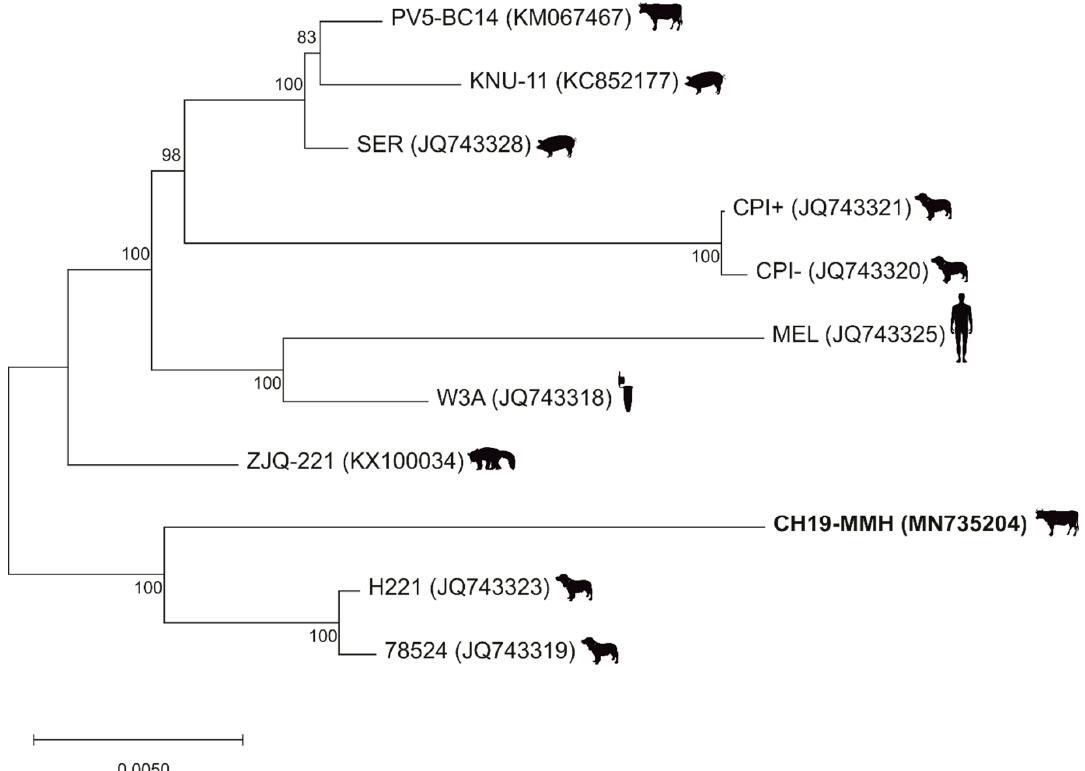
Figure 2. Phylogenetic analyses show an outstanding position of the PIV5 CH19-MMH strain. A PIV5 maximum likelihood tree based on selected full-length nucleotide sequences. PIV5 strain names